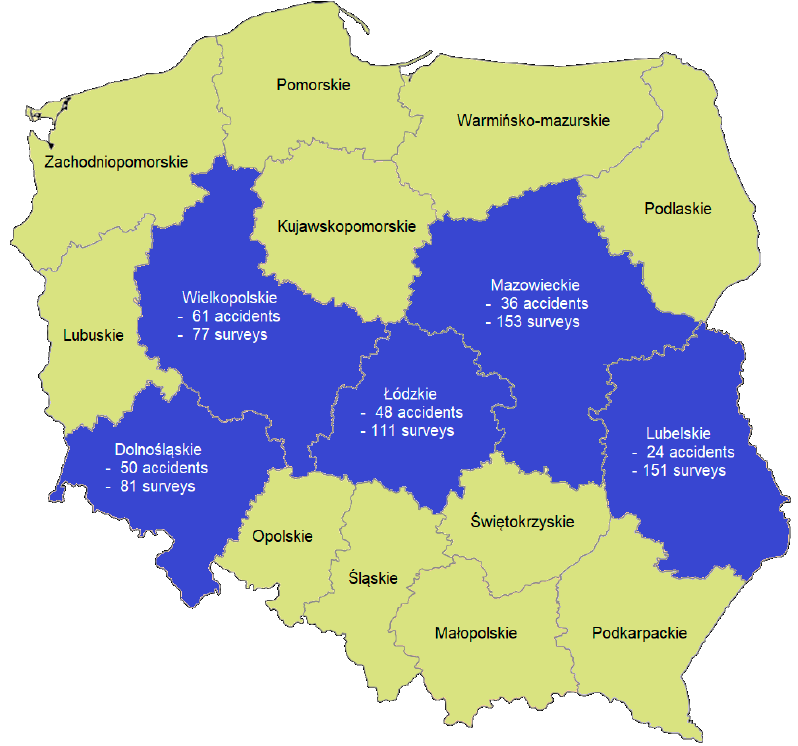
Figure 1. The map of the sites in Poland where the research was realized (own elaboration).